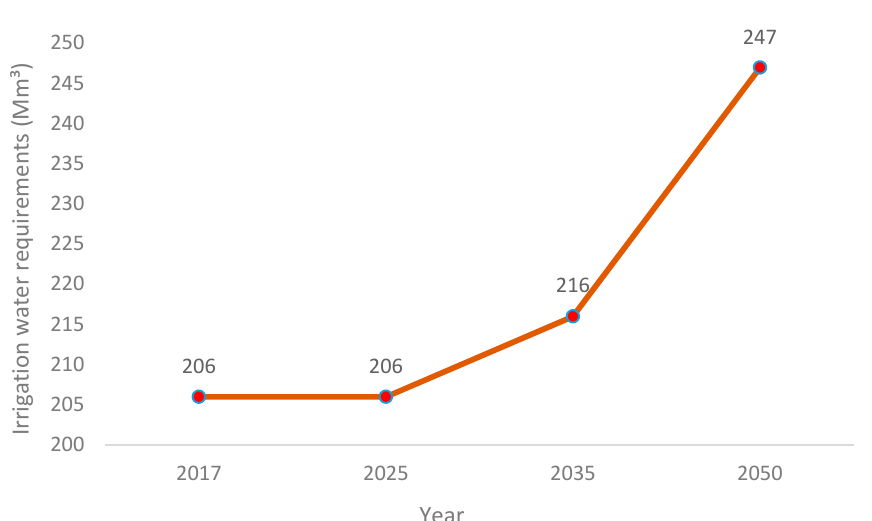
Figure 4. Population and water demand projection of Kano Metropolis.